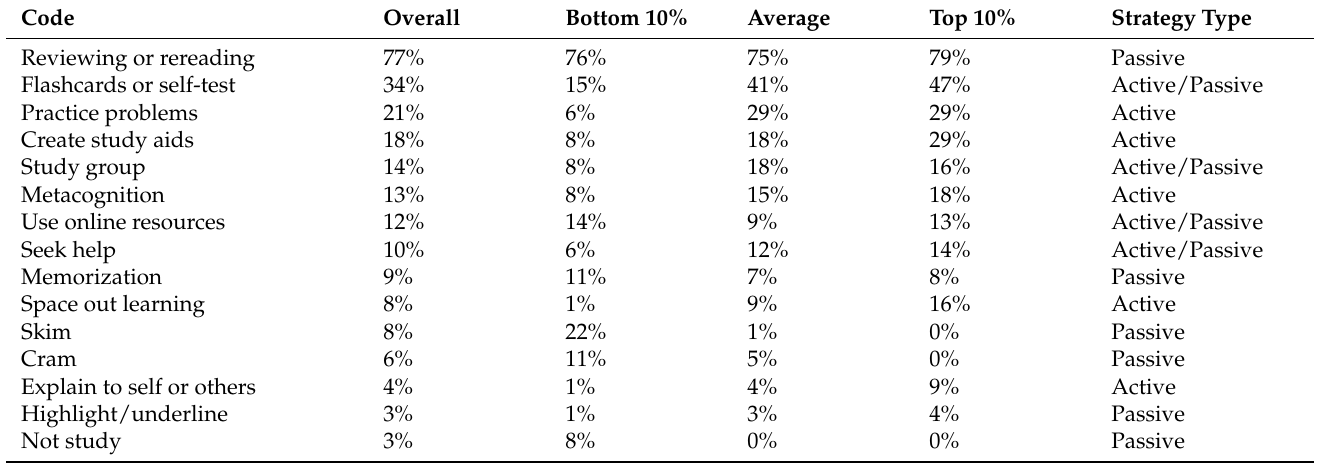
Table 4. Qualitative Coding Categorizing Learning Strategies by